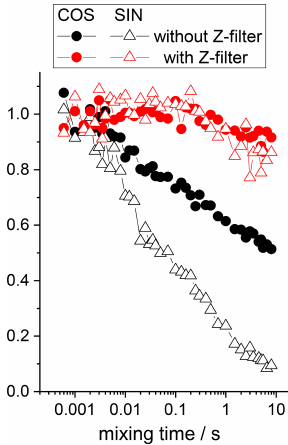
Figure 9. 13 C (carbonyls, natural abundance) CSA CODEX mix- ing time dependences in 15 N-enriched glycine measured with and without additional Z filter (Fig. 6). All decays were normalized to the same initial amplitude, the real ratio between the amplitudes of SIN and COS components is 0.7 for both experiments; 80kHz CW 1 H decoupling and 35kHz CW 15 N decoupling during the de(re)phasing periods were applied. MAS 22kHz, NT R 2ms, Z - filter delay 20ms, CP contact time